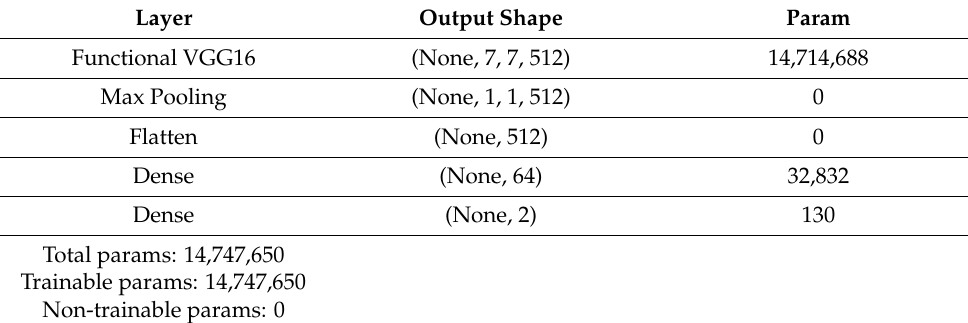
Table 3. Totally trained model’s summary.